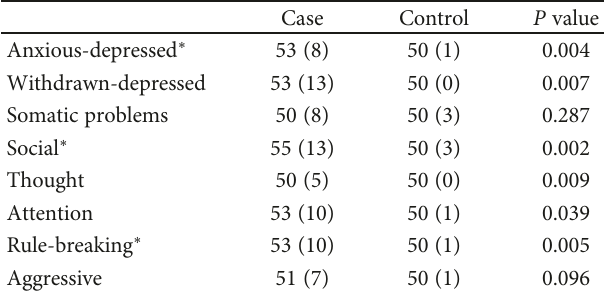
Table 5: Syndrome scale T scores in patients with XY DSD as compared to the control